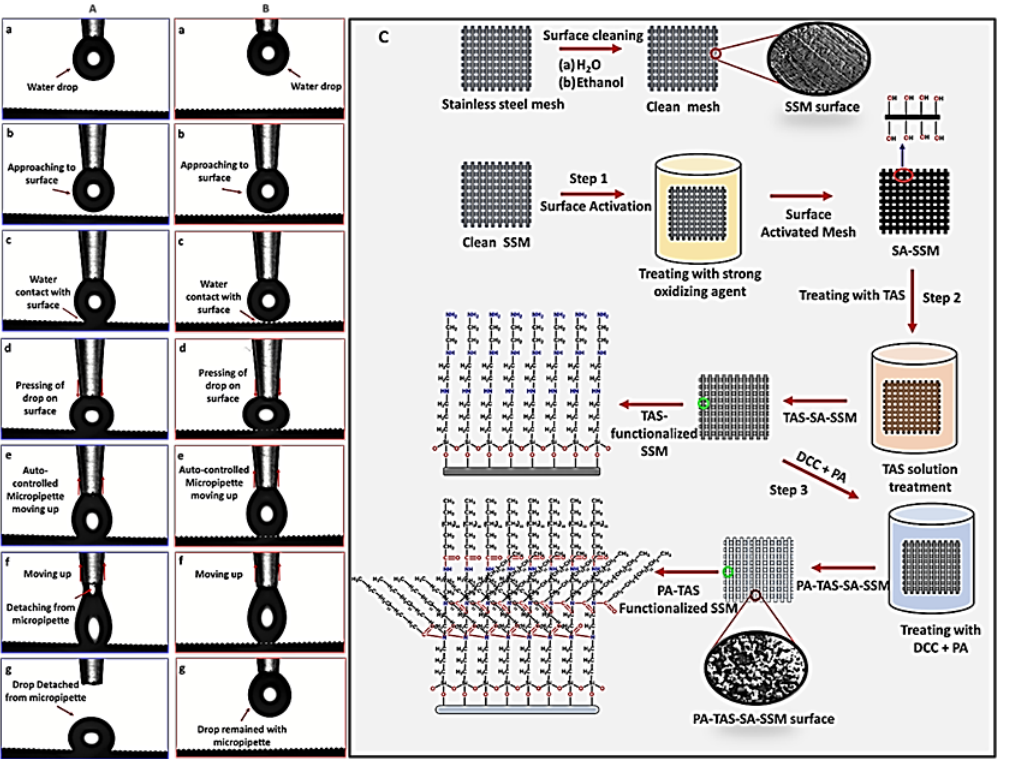
Figure 5. Response of water drop controlled by auto-controlled micropipette on the surface of the ( A ) SSM and ( B ) PA-TAS-SA-SSM. (a) Waterdrop produced by the micropipette, (b) Waterdrop approaching the surface, (c) Waterdrop contact with the surface, (d) Drop pressing on the surface, (e) Auto controlled micropipette moving up, (f) Continuation of upward movement, and (g) Auto-controlled micropipette pulled over. ( C ) Schematic stepwise illustration of the fabrication of the PA-TAS-SA-SSM [114]. Reprinted with permission from Ref. [114]. Copyright 2021 Elsevier Ltd. All rights reserved.